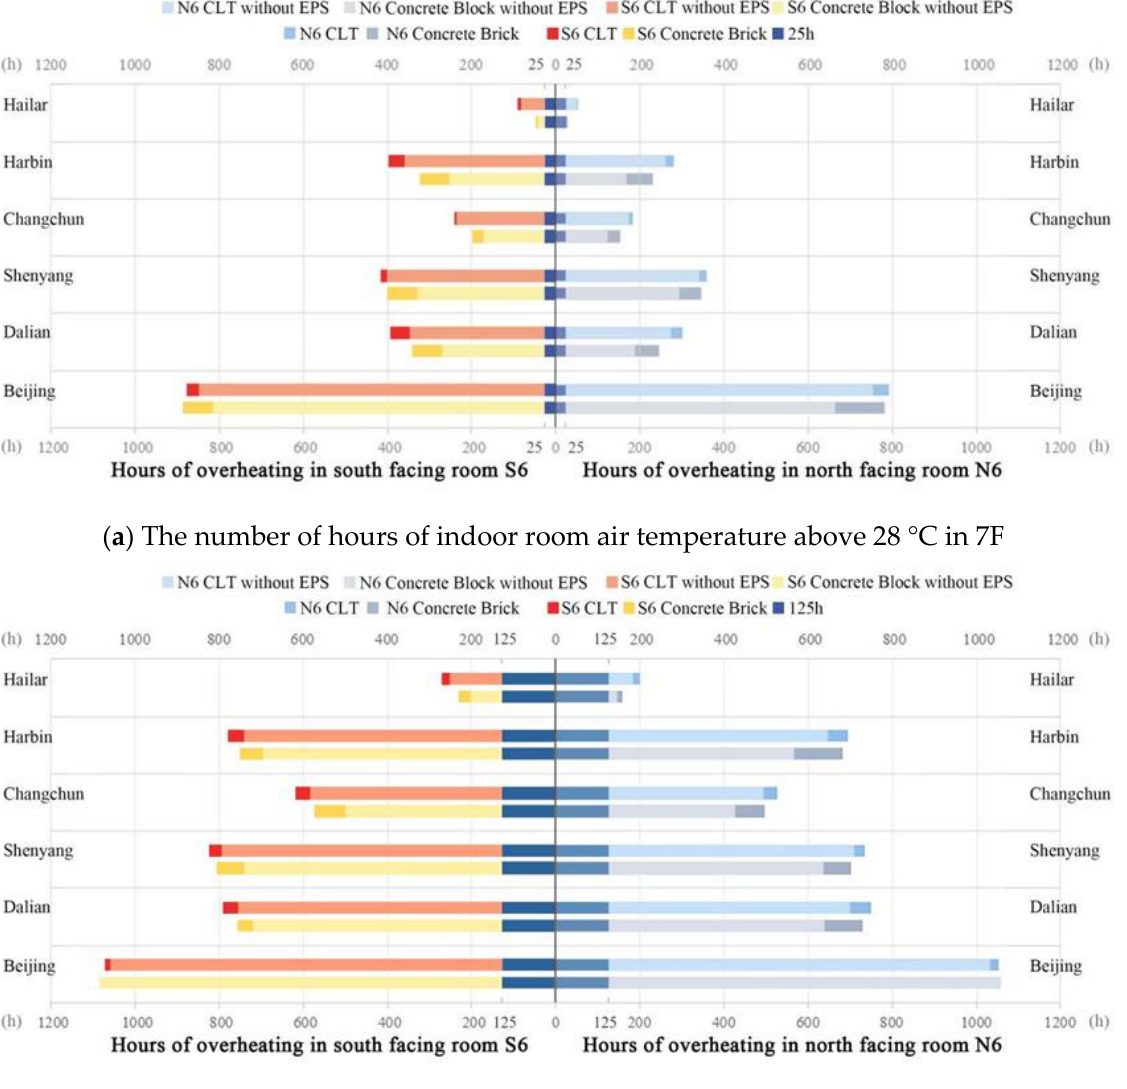
Figure 11. Comparison of hours of overheating in concrete and CLT buildings with and without insulation in six cities.